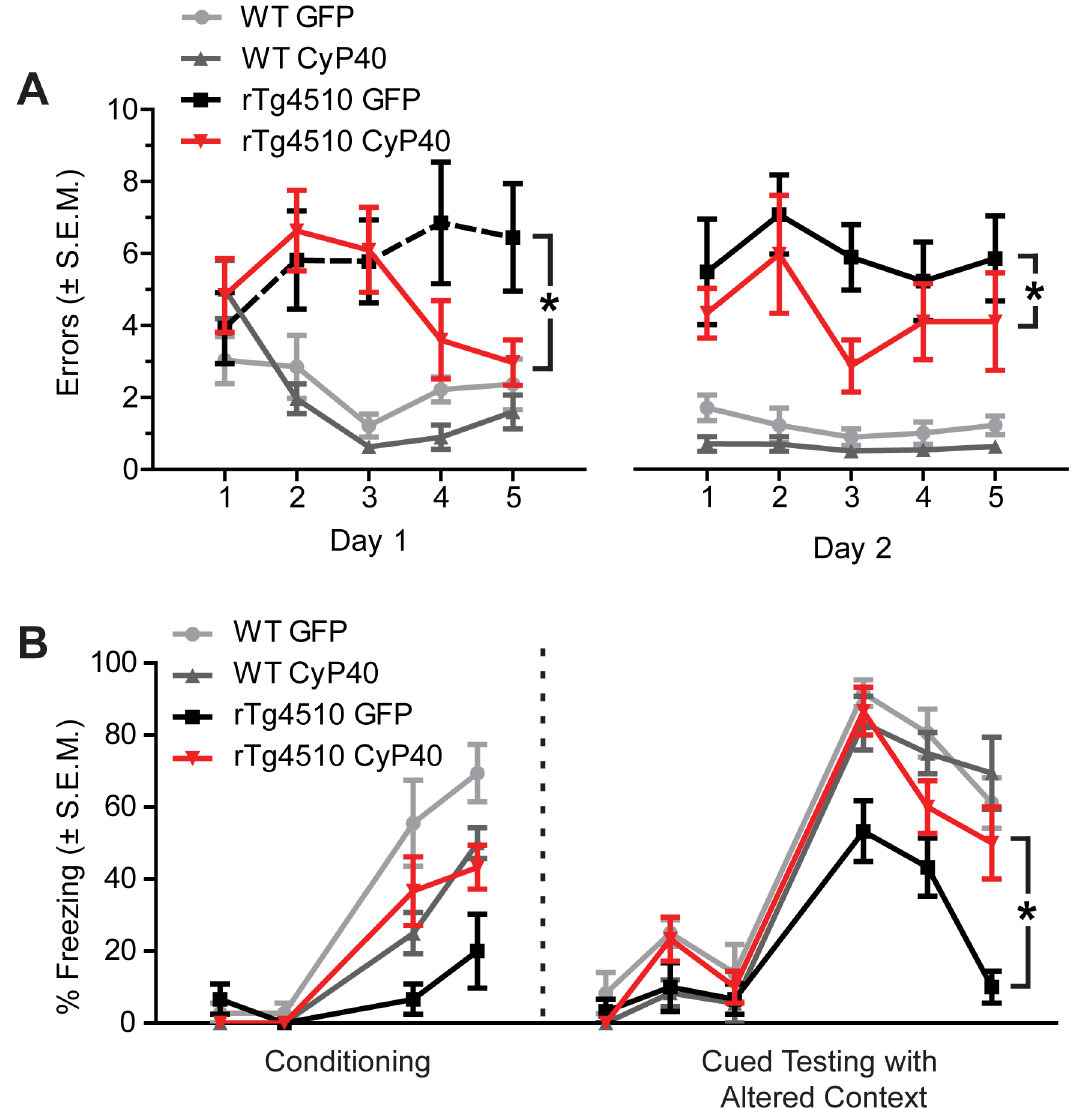
Fig 4. Cyclophilin 40 (CyP40) rescued tau-induced cognitive deficits. (A) Radial-arm water maze spatialmemory analysisof adeno-associated virus serotype 9–greenfluorescentprotein (AAV9-GFP) injected wild-type(wt) ( n = 9), AAV9-CyP40injectedwt ( n = 10), AAV9-GFP injectedrTg4510 mice ( n = 9), and AAV9-CyP40injectedrTg4510 mice ( n = 10). Data were analyzedby two-way ANOVA, and the significantresults were followedby Tukey post hoc tests ( * p < 0.05). (B) Percent freezingin the cued fear conditioning task ( n = 6 for each wt group and n = 5 for each transgenic group). Data were analyzedby two-way ANOVA, and the significantresults were followedby Tukey post hoc tests ( * p < 0.05). The numericaldata used in figure can be found in S1 Data. SEM; standard error of the